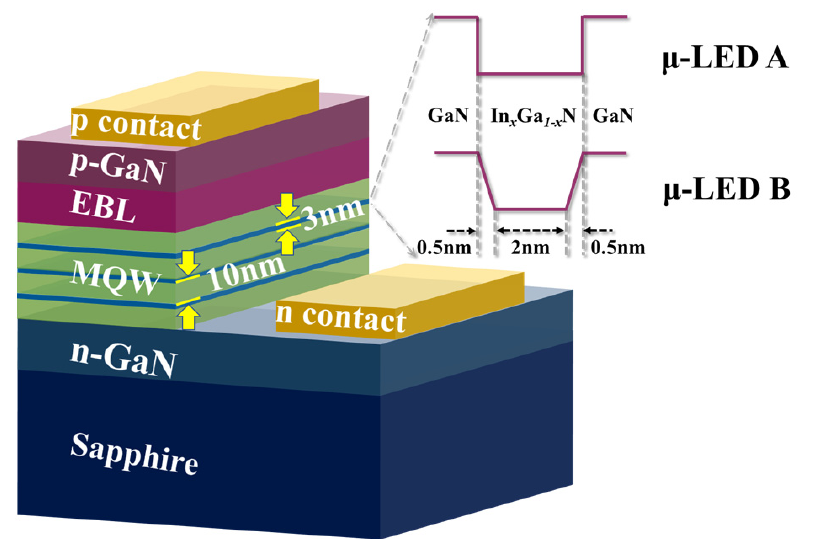
Figure 1. μ -LEDs with different structures for simulation: μ -LED A with conventional QWs and μ - Figure 1. µ -LEDs with different structures for simulation: µ -LED A with conventional QWs and µ -LED B with trapezoidal LED B with trapezoidal QWs.